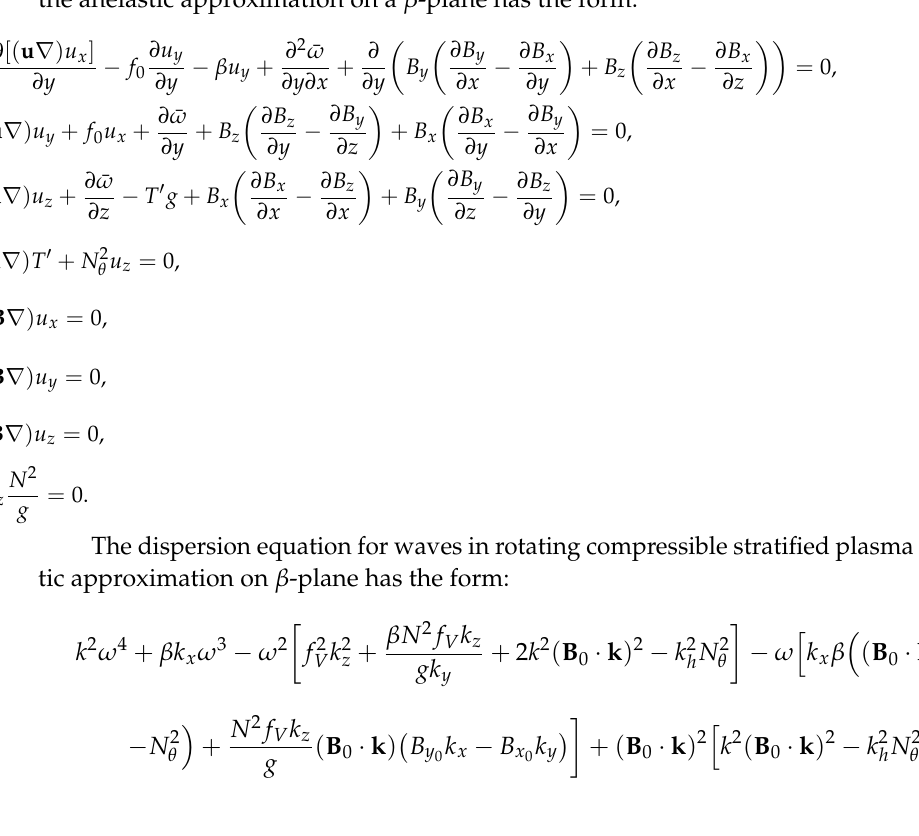
; ( b ) 1—compressible magnetogravity wave ω mg and Bz